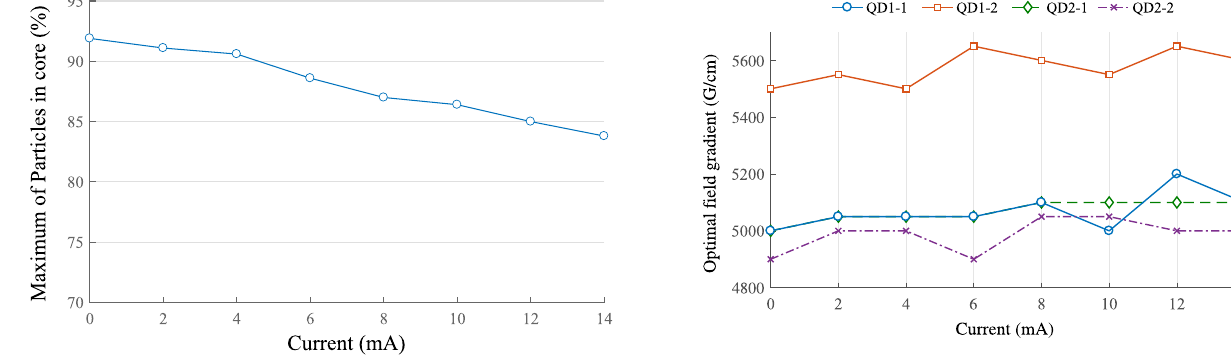
FIG. 3. Plot of maximum beam quality at different values of deuteron beam current.